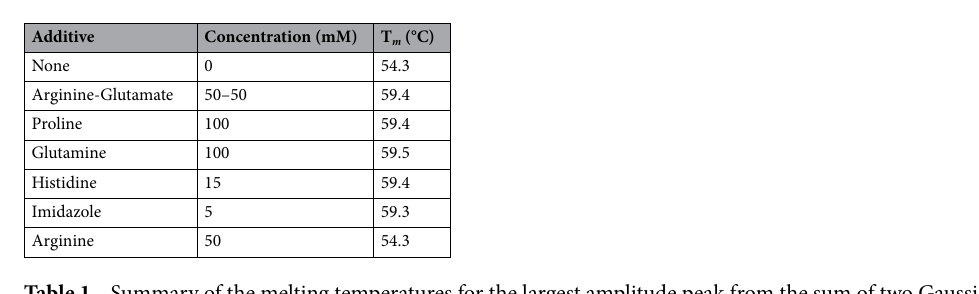
Table 1. Summary of the melting temperatures for the largest amplitude peak from the sum of two Gaussians fit to the first derivative of fluorescence with respect to temperature for each of the additive conditions.